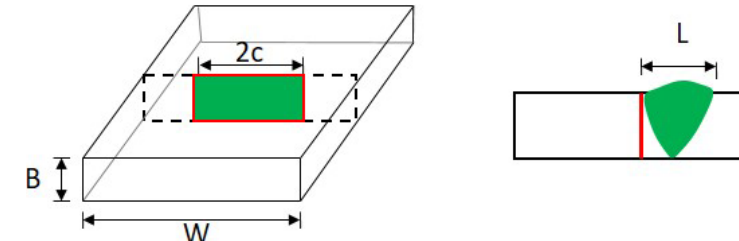
Figure 26. Through-thickness crack geometry diagram. Table 7. Inputs for probabilistic fatigue and fracture mechanics